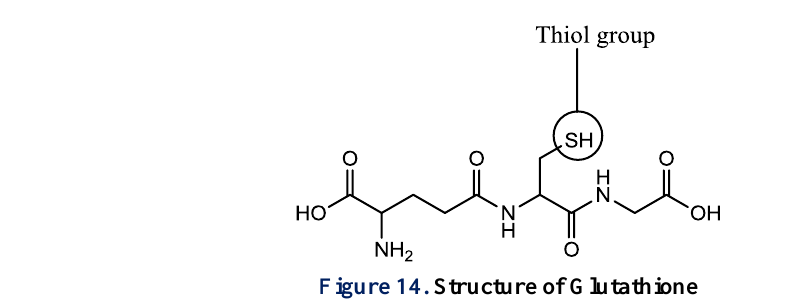
Figure 13. Reaction scheme for the reduction of Hydrogen peroxide.